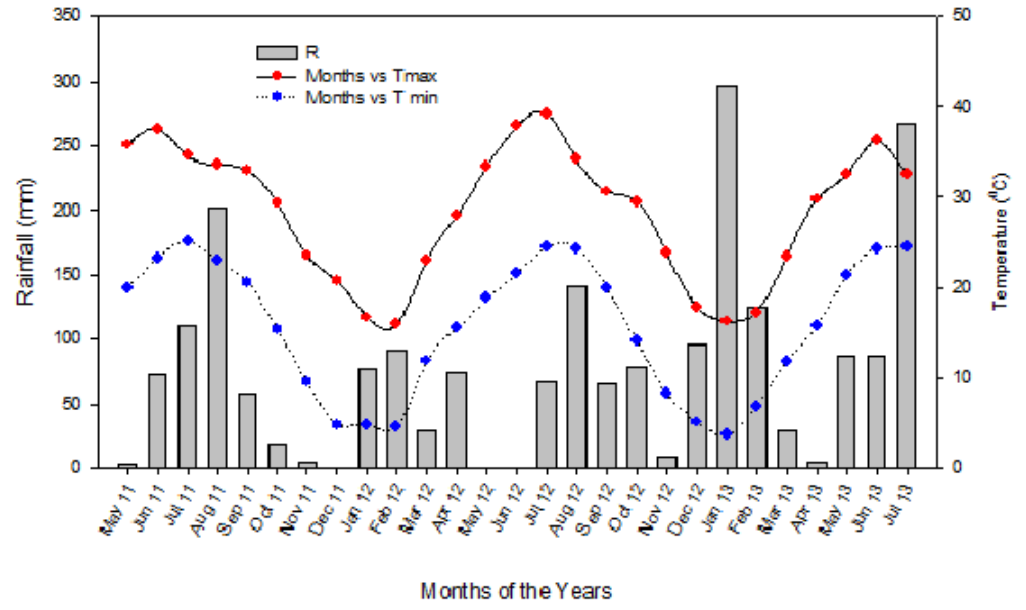
Figure 1. Weather data for the rice-wheat cropping system during 2011–2012 (year one) and 2012–2013 (year